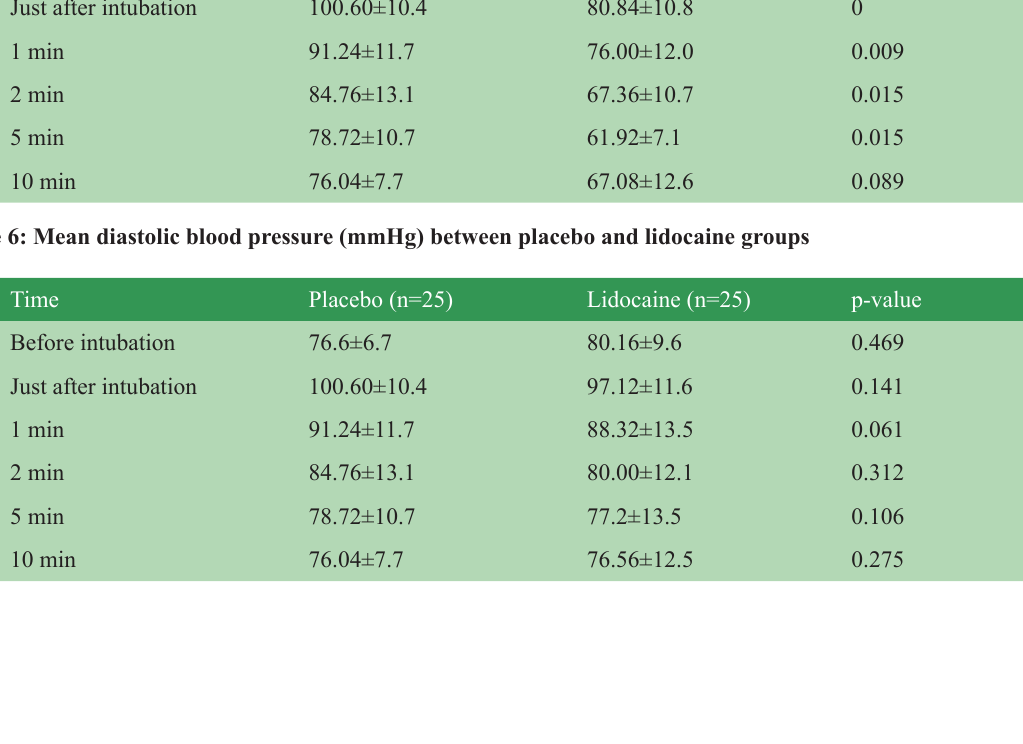
Table 5: Mean diastolic blood pressure (mmHg) between placebo and esmolol groups Time Placebo (n=25) Esmolol (n=25) p-value Before intubation